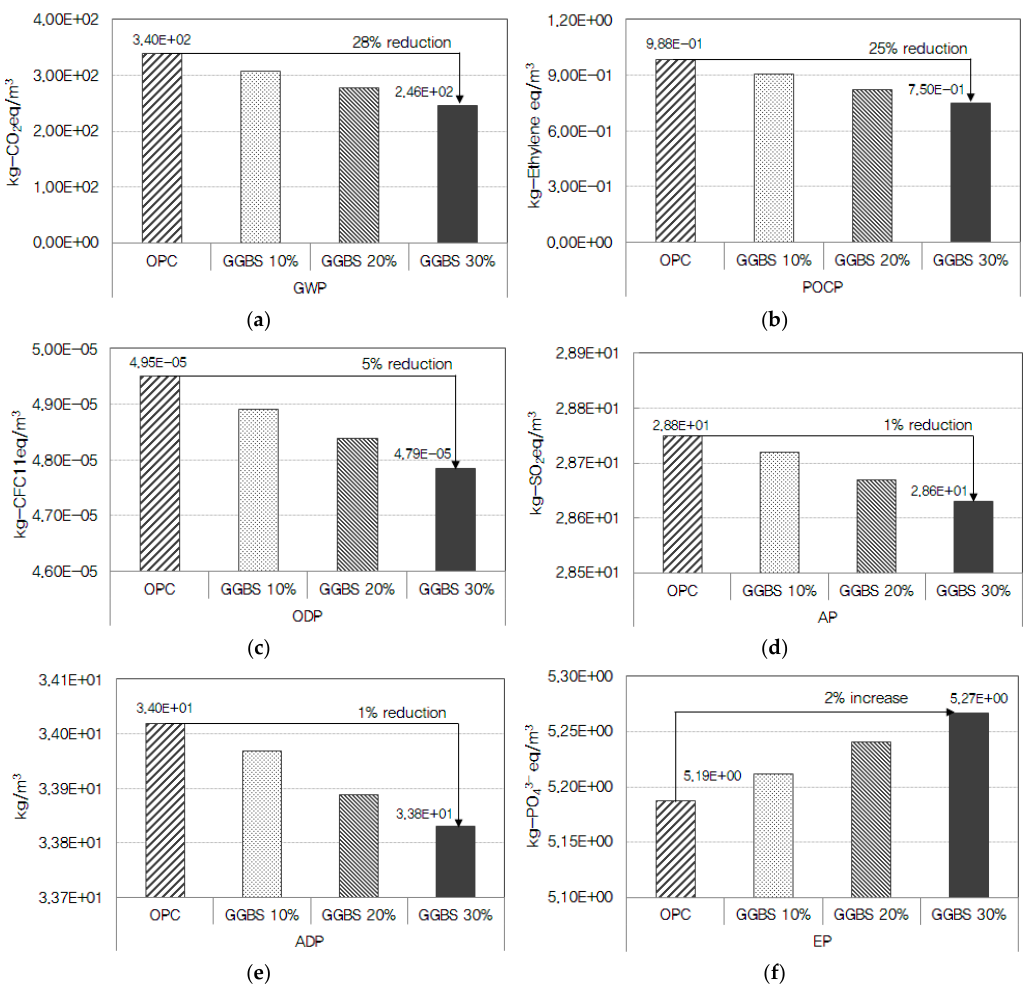
Figure 5. Analysis of environmental impacts according to the mix ratio of GGBS: ( a ) global warming potential (GWP); ( b ) photochemical ozone creation potential (POCP); ( c ) ozone depletion potential (ODP); ( d ) acidification potential (AP); ( e ) abiotic depletion potential (ADP); and ( f ) eutrophication potential (EP).